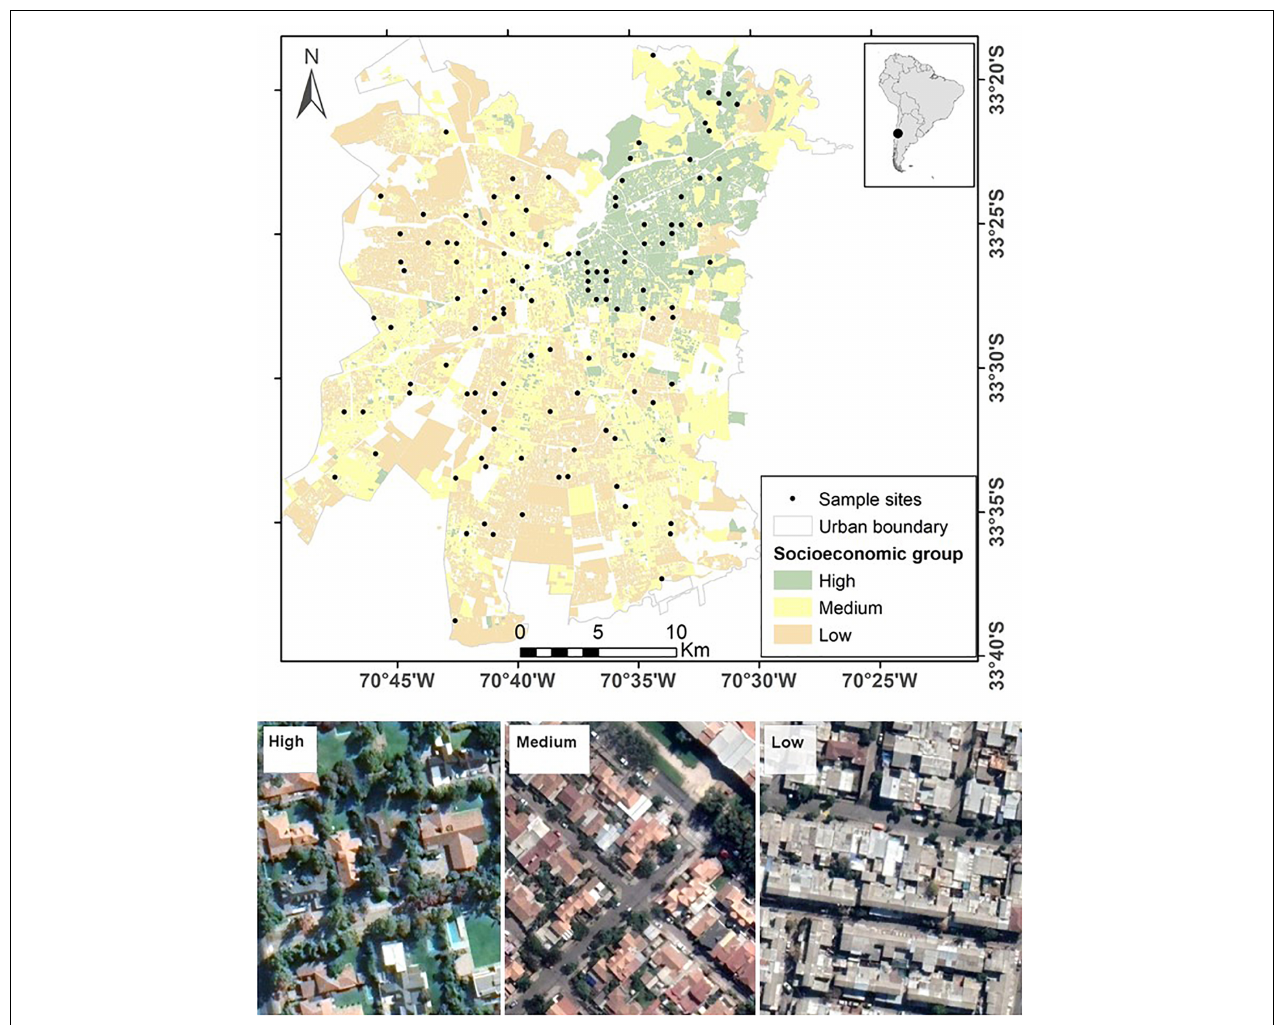
FIGURE 1 | Sample sites and socioeconomic groups in Santiago de Chile. An example of a sample site for each socioeconomic group is provided using satellite imagery from Google Earth. Source of socioeconomic groups